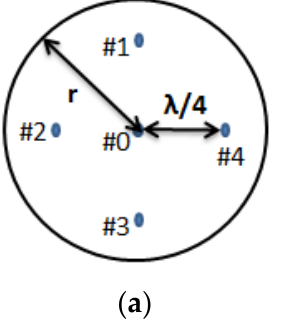
Figure 3. ( a ) Geometry of the proposed ESPAR antenna; ( b ) simulation view of the proposed ESPAR antenna.